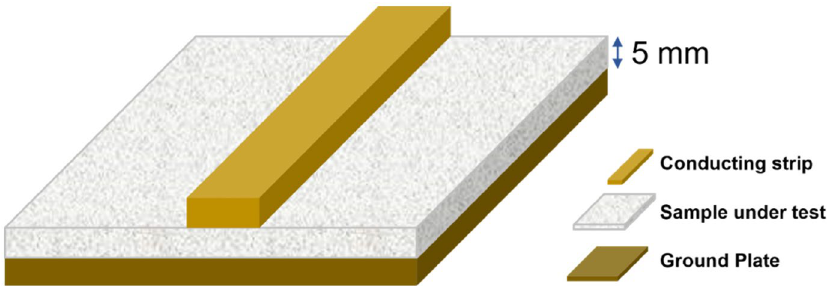
Figure 11. Schematic illustration of the layout of sample for microstrip line